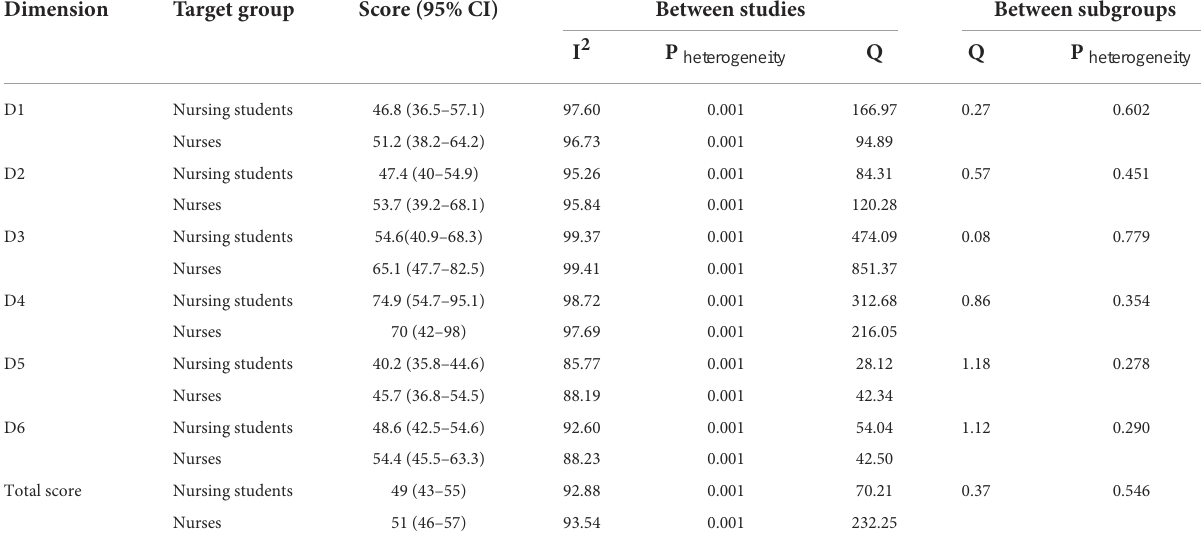
TABLE 3 Scores of different dimensions of PU prevention by target group.